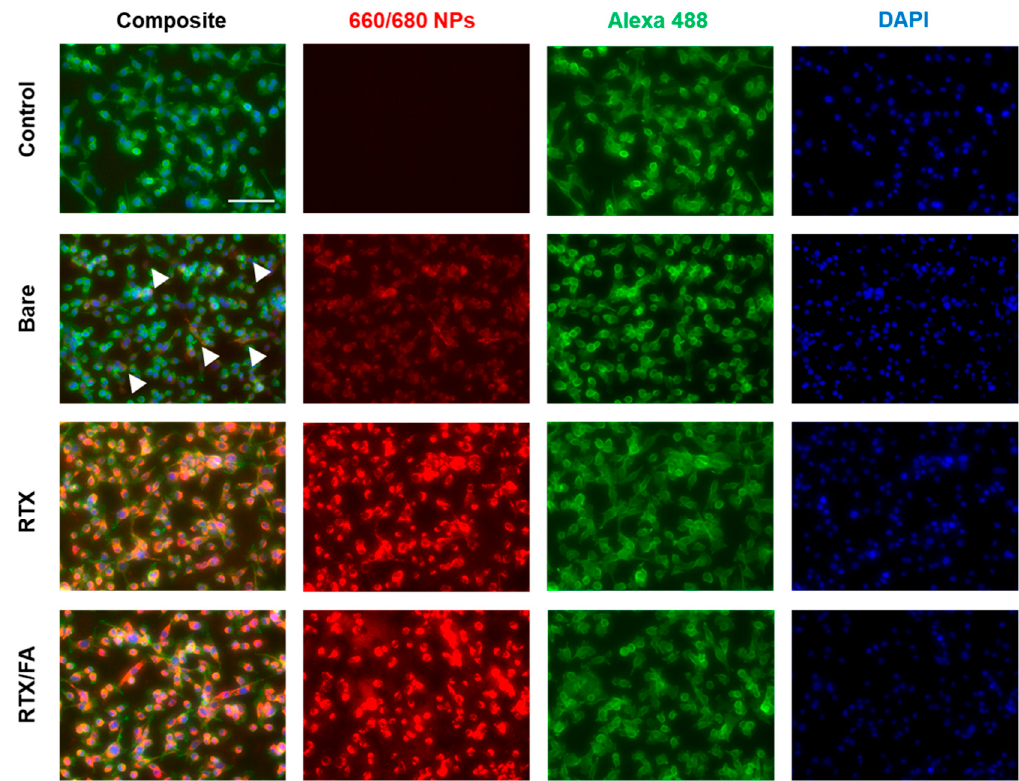
Figure 4. Cellular uptake of LbL NP formulations in vitro via fluorescence microscopy show an increase in red signal due to higher uptake of NPs, which is highest in the RTX and RTX/FA images. Scale bar indicates 100 µm.